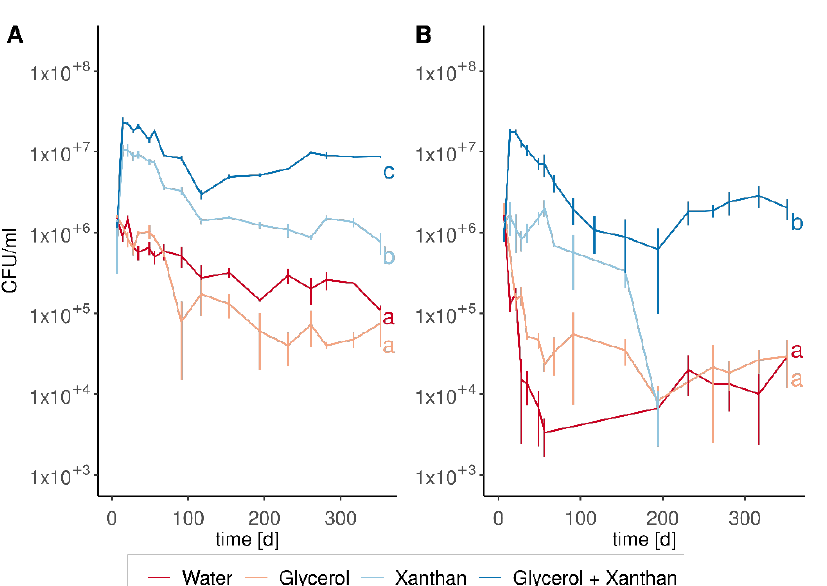
Figure 3. M. pulcherrima remains viable during long-term storage in liquid formulations and at 22 °C . M. pulcherrima was stored in water, glycerol (20%), xanthan (5 g/L), or a combination of xanthan and glycerol and kept at 22 °C ( A ) or 30 °C ( B ). The CFU was determined by serial dilutions and counting of colonies on PDA plates. After 261 days, contaminations were observed in some replicates of the samples containing glycerol or xanthan. Subsequently, these samples were omitted from determination of cell viability. Numbers are represented in a logarithmic scale. Data points represent the means and standard errors of three replicates. Letters indicate statistical significance determined by a two-sided Kruskal–Wallis test with Dunn multiple comparisons test and Benjamini–Hochberg correction ( p < 0.05).